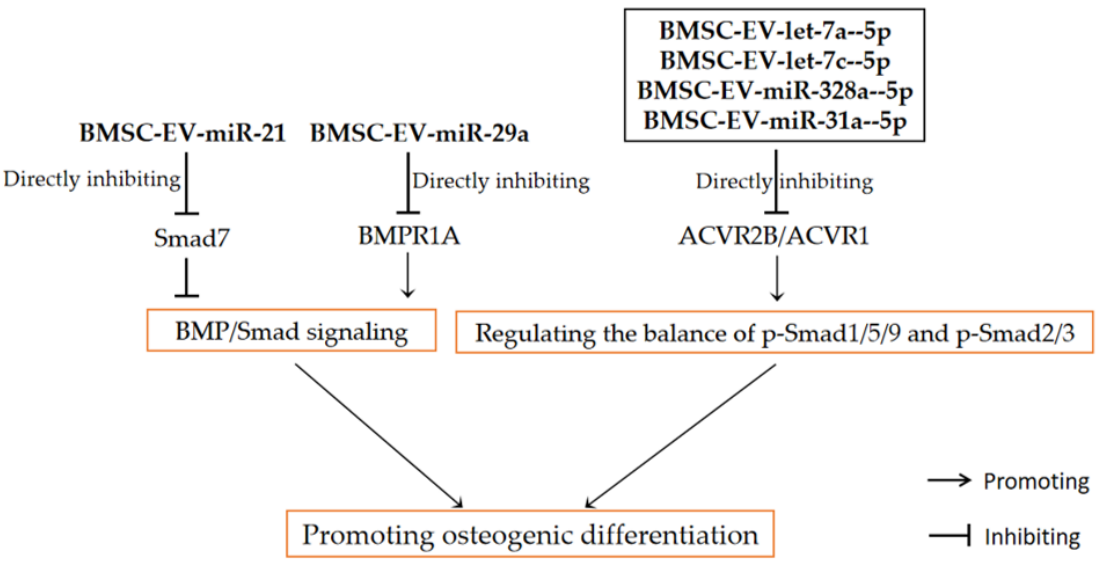
Figure 2. BMP/Smad signaling mediates the regulation of BMSC-EV-miRNAs on bone metabolism. 3.4. Angiogenesis Mediating the Regulation of BMSC-EV-miRNAs on Bone Metabolism Bone is a specialized (i.e., mineralized) connective tissue that is highly vascularized. Blood vessels provide bone tissue with the oxygen, nutrients and growth factors needed for growth and development [112]. Coupled angiogenesis and osteogenesis are critical for bone tissue repair and regeneration, such as fracture healing [113]. Previous studies have shown that angiogenesis precedes osteogenesis in bone remodeling and repair [114]. An- giogenesis dysfunction disrupts bone growth and remodeling, leading to OP or poor frac- ture healing [112]. Numerous studies have reported that BMSC-Exos may maintain bone homeostasis by regulating angiogenesis. BMSC-Exos promotes nonunion healing by pro- moting angiogenesis and osteogenesis [115]. Another study demonstrated that BMSC- Exos could significantly stimulate bone regeneration and angiogenesis in an ovariecto- mized (OVX) rat model of the critical-sized calvarial defect [85]. However, the above stud- ies did not further explore the specific mechanism of BMSC-Exos regulation of bone blood vessels. Previous studies have focused on the regulation of miRNAs on angiogenesis [116]. Therefore, the abundant miRNAs contained in BMSC-Exos may be involved in mediating the regulation of BMSC-Exos on bone angiogenesis. Lu et al. [9] revealed that miRNA-29a is enriched in BMSC-Exos, which can be taken up by human umbilical vein endothelial cells (HUVECs) to promote the proliferation, migration and tube formation of HUVECs, thereby promoting angiogenesis. Vasohibin 1 (VASH1) was identified as a direct target of miR-29a, mediating the effects of BMSC-Exo-miR-29a on angiogenesis [9]. Further studies showed that overexpression of miR-29a derived from BMSC-Exos showed a strong ability to promote angiogenesis and osteogenesis, while the inhibition of miR-29a derived from BMSC-Exos showed the opposite effect [9]. The above findings suggest that miR-29a in BMSC-Exos promotes angiogenesis and osteogenic differentiation by targeting VASH1. A newly discovered vascular subtype, type H vessels, has been reported to recruit osteopro- genitor cells and combine osteogenesis with angiogenesis [117], which is considered a cru- cial event during bone remodeling and repair [118]. However, this study did not find any genes associated with H-type angiogenesis among the predicted target genes of miR-29a [9], which means that BMSC-Exo-miR-29a may regulate angiogenesis during osteogenesis through yet-to-be-discovered signal transduction. Another study found that miR-214-3p was significantly increased in BMSC-Exos from OVX mice but significantly decreased in